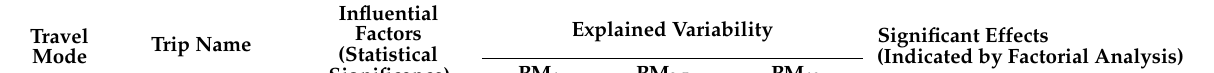
Table 5. Explained variability (%) of influential factors in PM concentrations and their